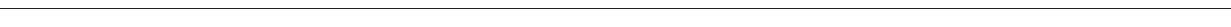
Fig. 4 R292P mutation disables the CaM-shuttling function of γ CaMKII and inhibits activity-dependent gene expression, late-LTP, and spatial memory formation. a MWM test of WT or γ CaMKII exc-KO mice 3 weeks after injection with HA- γ CaMKII (WT h ) lentivirus, HA- γ CaMKII R292P lentivirus, or saline bilaterally in the hippocampus ( n = 10 mice for each group). Inset, representative injection with lentivirus encoding GFP, demonstrating localization of viral infection. Scale bar, 500 μ m. b CaM and c-Fos staining in CA1 of γ CaMKII exc-KO mice injected with HA- γ CaMKII or HA- γ CaMKII R292P. Slices are from mice used in a that were sacri fi ced 1 h post training on day 4. Scale bar, 20 μ m. c Percentage of c-Fos-positive cells plotted against mean nuclear CaM in CA1 1 h after MWM training in WT or γ CaMKII exc-KO mice injected with saline, or in γ CaMKII exc-KO injected with HA- γ CaMKII or HA- γ CaMKII R292P (analysis after behavior in a ). Dotted line represents CaM (normalized to naive) or c-Fos nuclear value in naive mice ( n = 3 – 4 mice per condition). CaM and c-Fos values were signi fi cantly greater ( p = 0.0005 for CaM and p < 0.0001 for c-Fos) in γ CaMKII exc-KO mice injected with HA- γ CaMKII as compared to those injected with saline or HA- γ CaMKII R292P. d – f CaM, c-Fos, and γ CaMKII (HA-tag) staining in CA1 after MWM training, with each dot representing an individual sliced and stained section of CA1, each containing data from 100 – 140 pyramidal cells. Nuclear CaM value in d and e is normalized to exc-KO + saline. d Percent of c-Fos-positive cells plotted against mean nuclear CaM in WT (Adj. R 2 = 0.67) or γ CaMKII exc-KO mice injected with saline 1 h after the end of MWM training. e Percent of c-Fos-positive cells is plotted against nuclear CaM in γ CaMKII exc-KO mice, injected with either HA- γ CaMKII (Adj. R 2 = 0.72) or HA- γ CaMKII R292P, 1 h after the end of MWM training. f Percent of c-Fos-positive cells is plotted against average nuclear γ CaMKII (staining against HA tag) in γ CaMKII exc-KO mice, injected with either HA- γ CaMKII (Adj. R 2 = 0.91) or HA- γ CaMKII R292P (Adj. R 2 = − 0.053), 1 h after the end of MWM training. g – i γ CaMKII exc-KO or WT mice injected with HA- γ CaMKII R292P in CA1 were trained in the MWM. g No signi fi cant differences in escape latency during the acquisition phase of the MWM test. h Staining of HA and c-Fos in CA1 in mice sacri fi ced